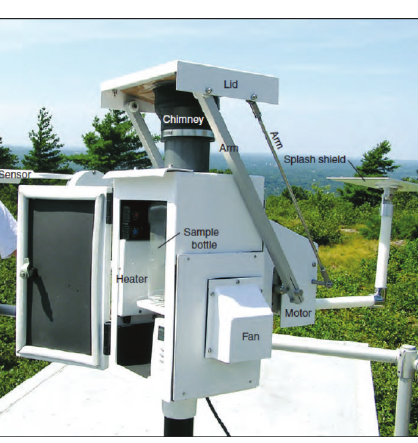
Figure 4: Newly designed wet-deposition sampler, Wet N-con System